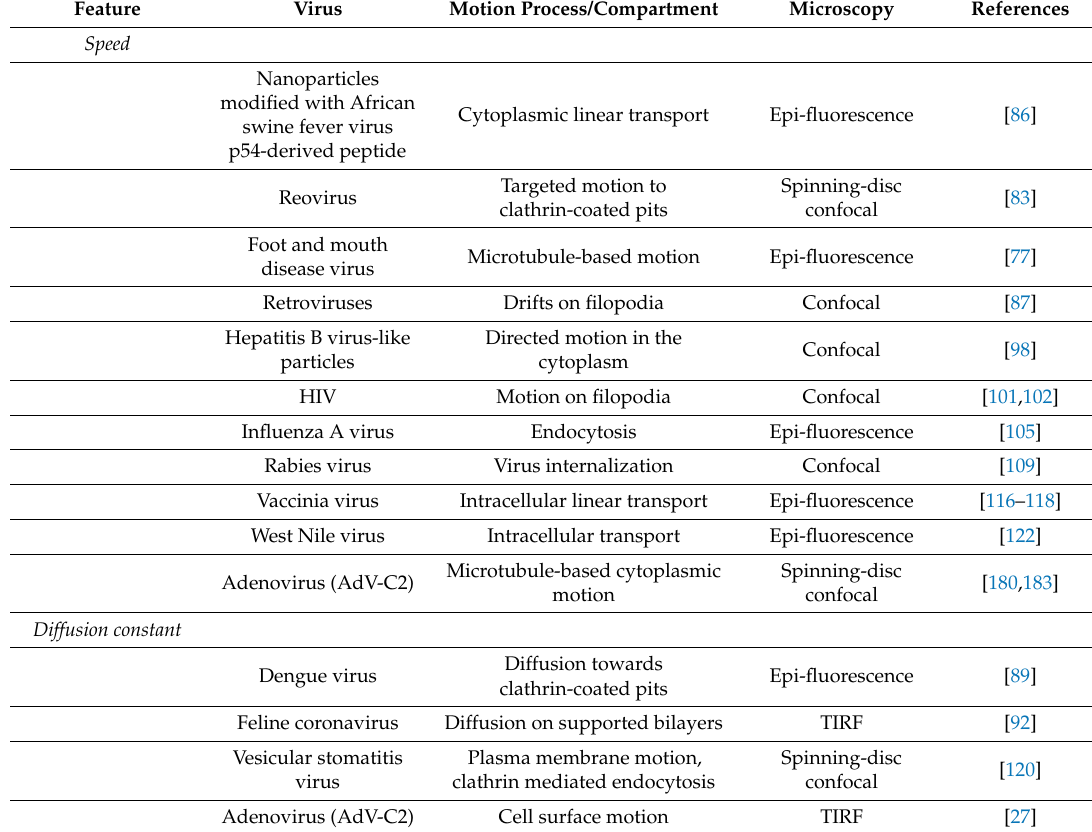
Table 5. Trajectory analyses extract a range of virus motion features. Total internal reflection (TIRF)